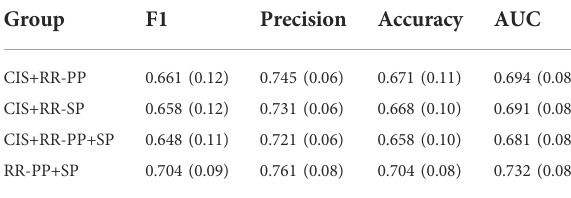
TABLE 8 Ablation study: Mean (st.dev) of the predictive performances of the ensemble model across the ten folds of the cross validation using Glasser 2016 atlas and multiclass binary